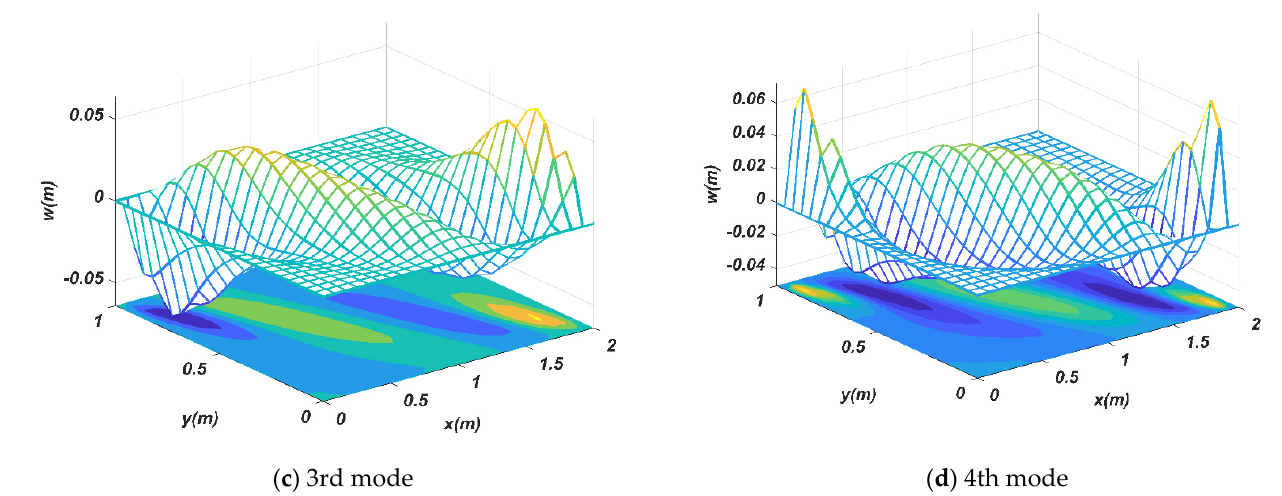
Figure 6. First four buckling mode shapes of a FG-saturated porous plate subjected to a shear load (SSSS, a = 2 m, b = 1 m).